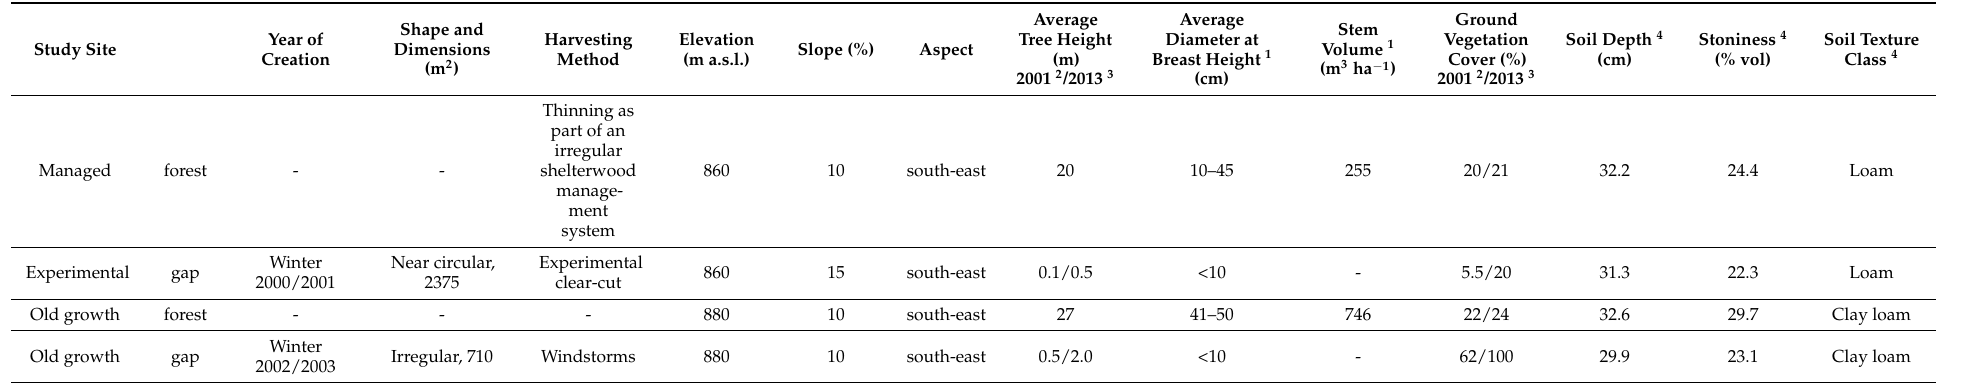
Table 1. General characteristics of the study sites and